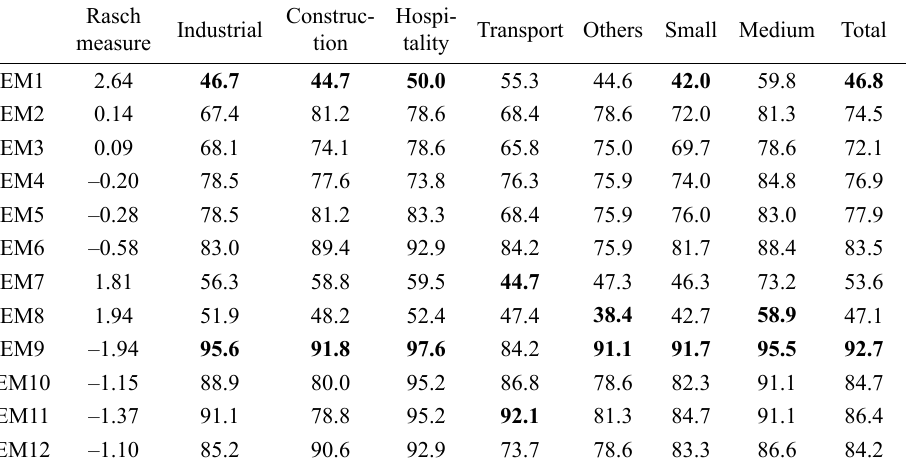
Table 4. Environmental practices applied by sector and size